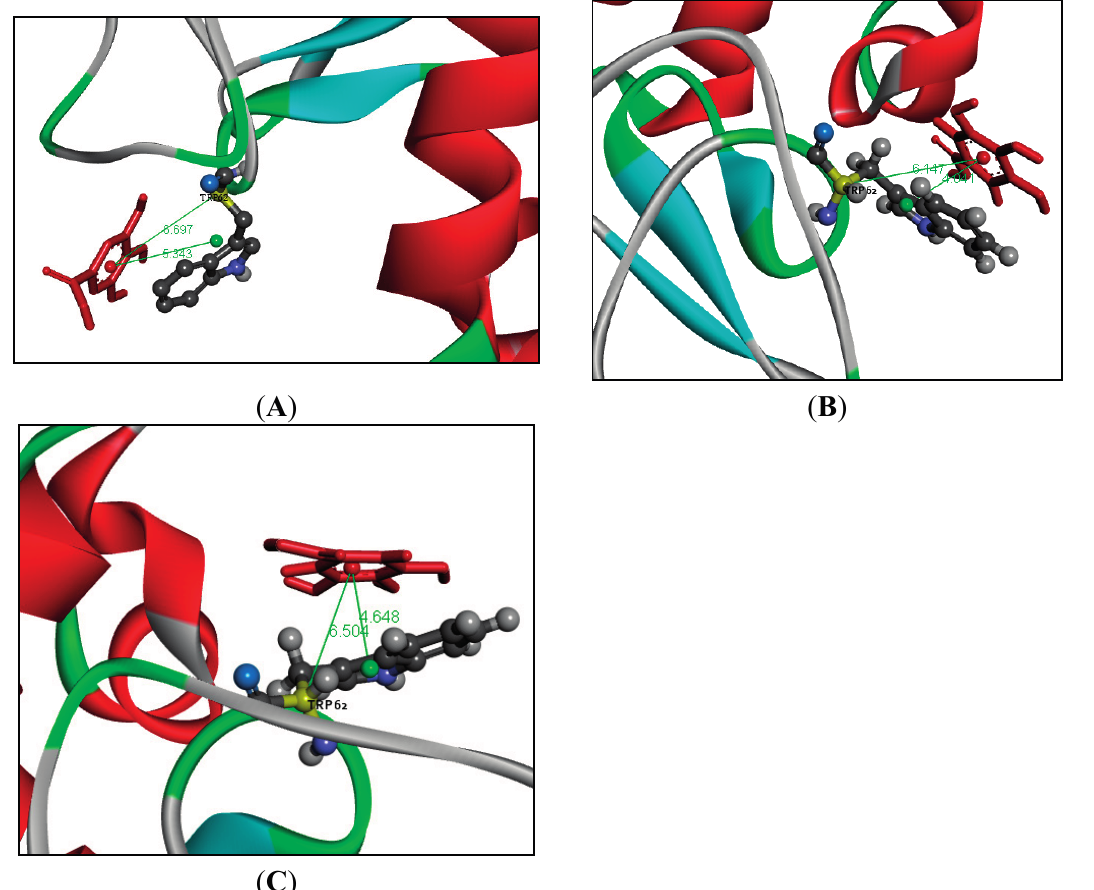
Figure 9. Distance map of GA to Trp62 of LYS, only picked Trp62 as a example. ( A ) The interaction mode between GA and LYS before MD simulation; ( B ) The interaction mode between GA and LYS after 298 K MD simulation; ( C ) The interaction mode between GA and LYS after 310 K MD simulations. (The ligand structure is represented using red stick model, and the red ball is the centroid of GA. The distances are remarked using green lines. The residue Trp62 is represented using a ball and stick model, the green ball represents the centroid of Trp and the yellow ball represents the C α of